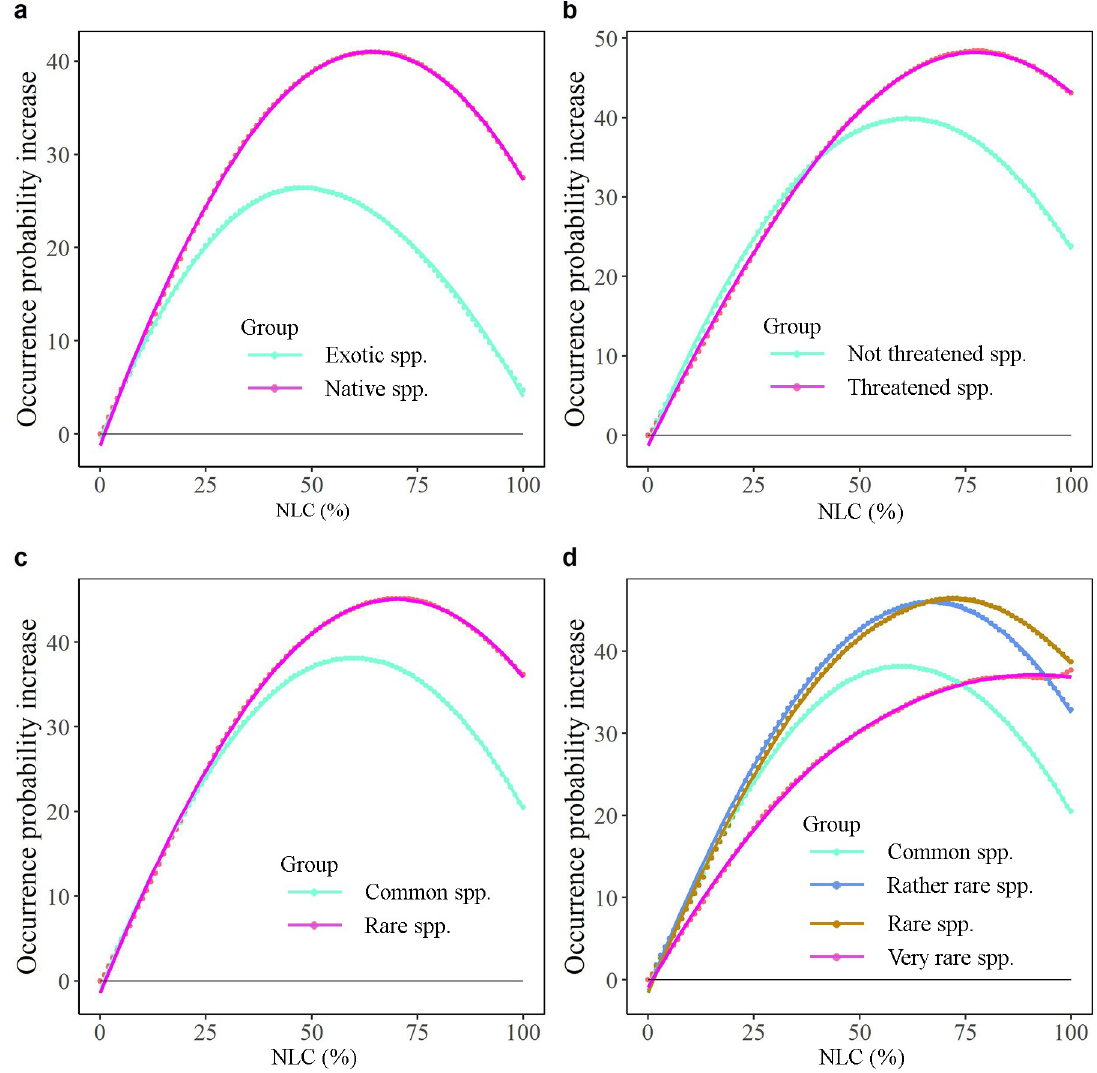
Fig 7. The average occurrence probability change (average occurrence probability change from 0% NLC to others, e.g. NLC at 1x1 km resolution increases from 0% to 11%) of different species groups. a, All native species vs exotic species. b, Threatened species vs not threatened species. c, Rare species vs common species. d, Rare species vs common species, but rare species are classified into three categories (i.e. very rare, rare, rather rare) according to the Red List of Vascular Plants of the Netherlands [26]. Lines represent the best- fit